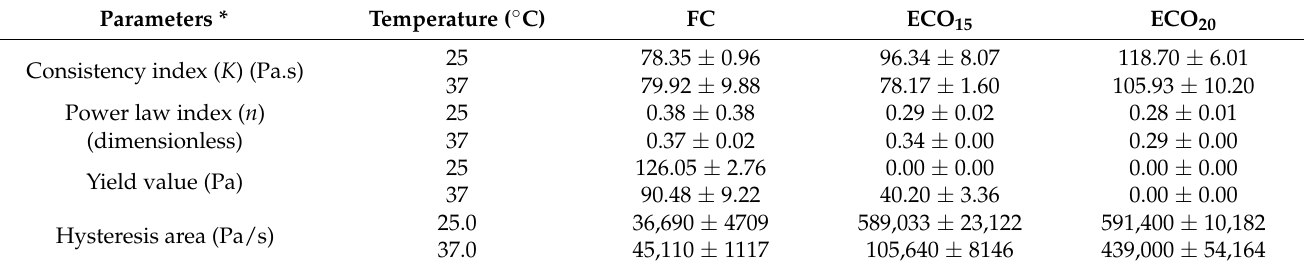
Table 3. Rheological parameters calculated for emulsion-filled gels (EFG) using Ostwald-de-Waele